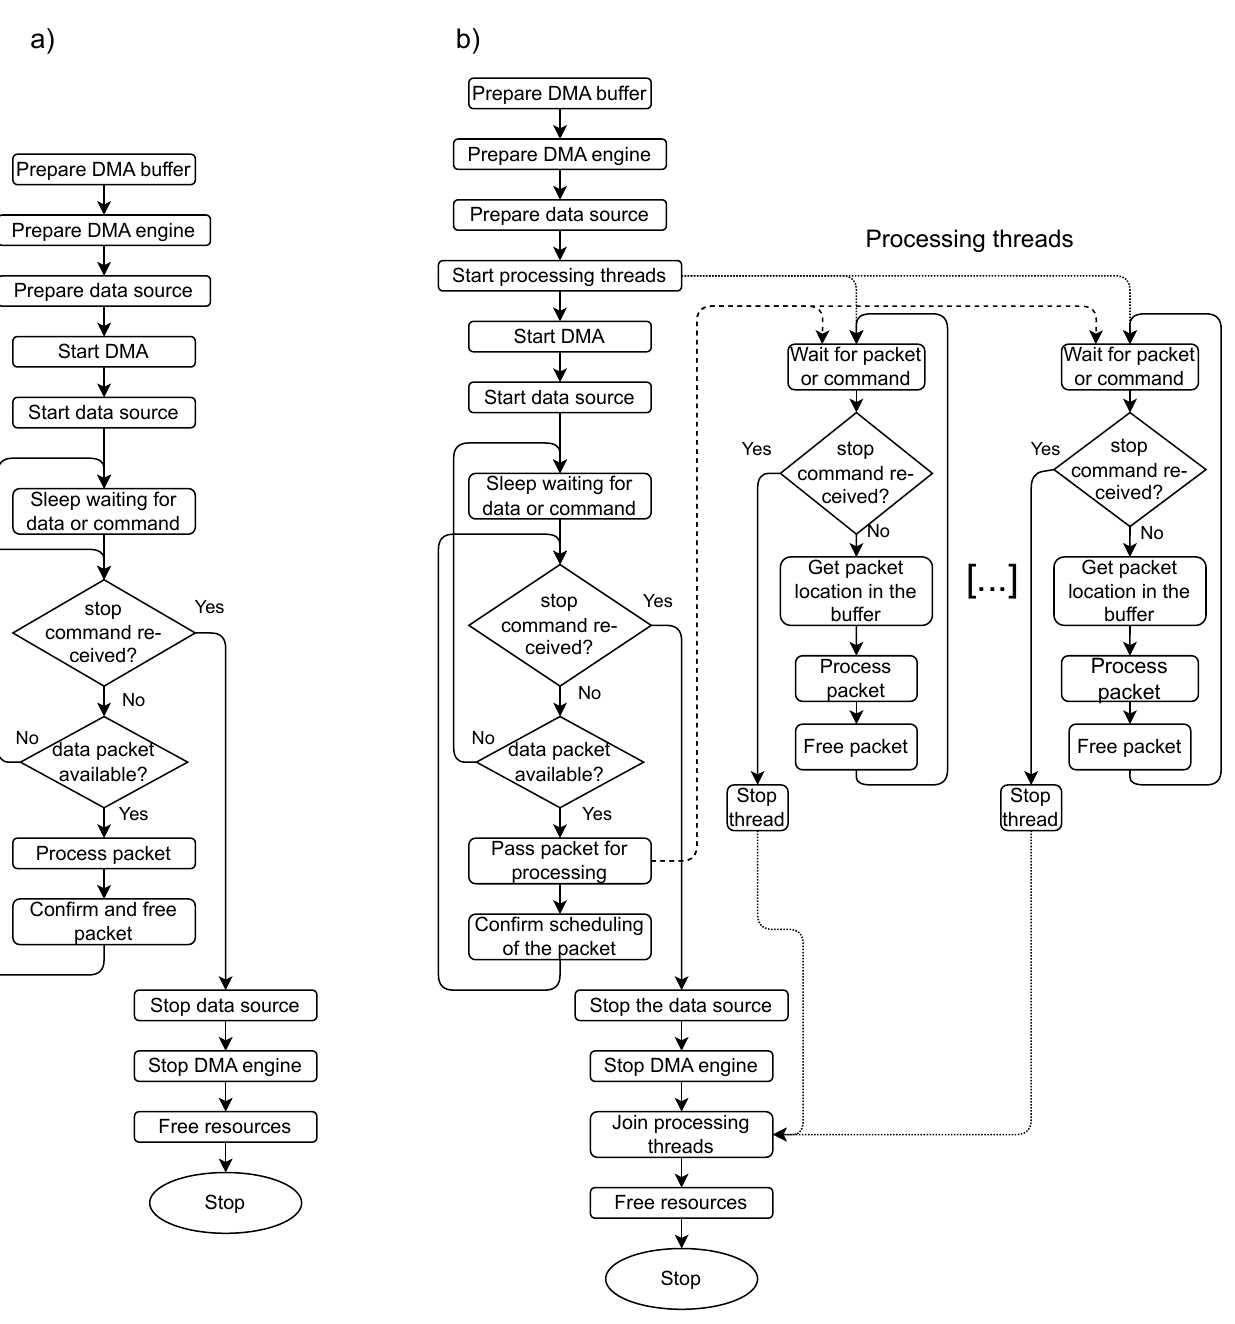
Figure 8. Two modes of operation of the data acquisition software; ( a ) single-packet mode—packets are received and processed sequentially, and the next packet is only handled after the previous one is fully processed and confirmed. This mode may be well-suited for recording the acquired data or debugging the system. ( b ) Multi-packet mode—packets are passed for processing to the data processing threads as they arrive. Multiple packets may be processed at the same time. This mode enables full utilization of multiple CPU cores in the system. It may be perfect if different data packets are processed independently (e.g., transferred to different nodes in the computing